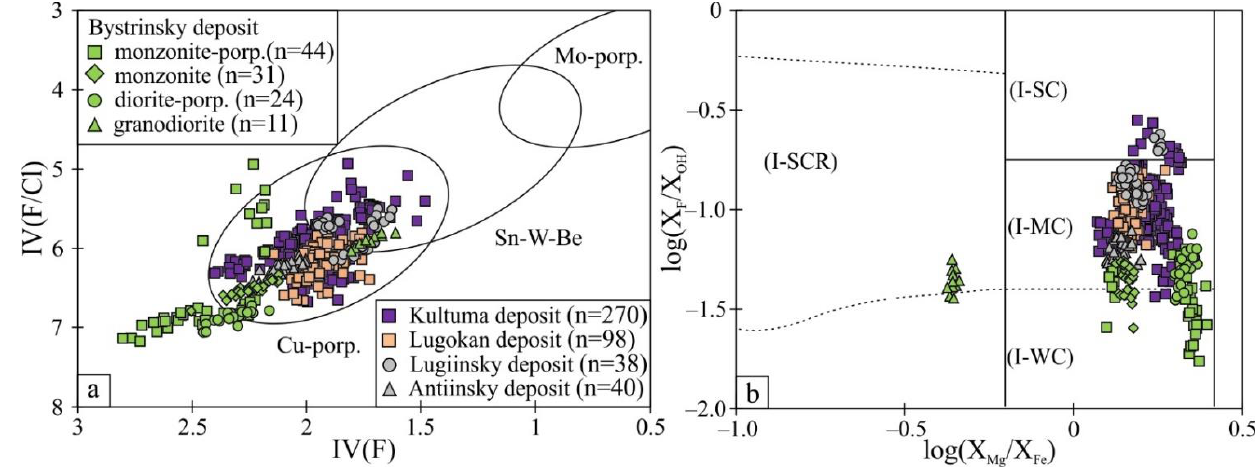
Figure 10. Chemical composition diagrams of biotite: ( a ) — intercept value IV(F) versus IV(F/Cl) showing the halogen content of biotite, fields of porphyry Cu, Sn-W-Be and porphyry Mo are from [35]; ( b ) — log(XMg/XFe) versus Log (XF/XOH), field boundaries are from [36,37]. The Log(XF/XOH) versus Log(XMg/XFe) diagram for biotites suggests magma